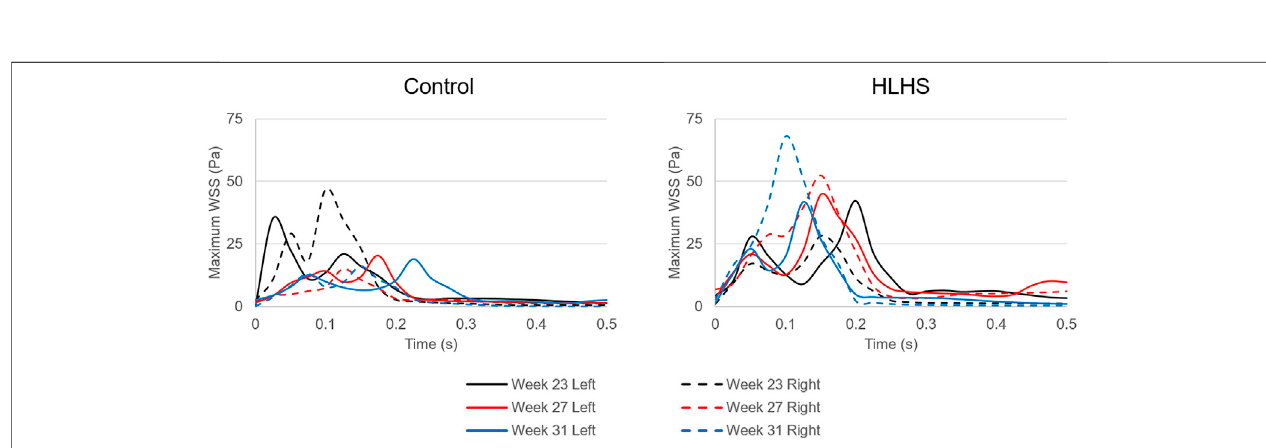
FIGURE 10 | Maximum WSS levels for the left and right sides of the control and HLHS hearts at weeks 23, 27, and 31.